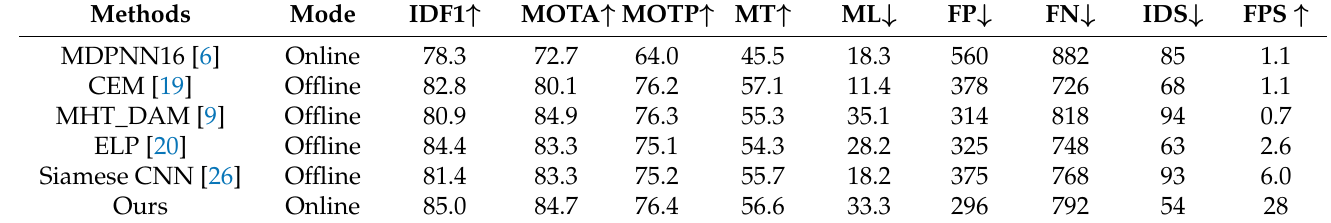
Table 4. Comparison with state of the art on the VolleyTrack dataset.